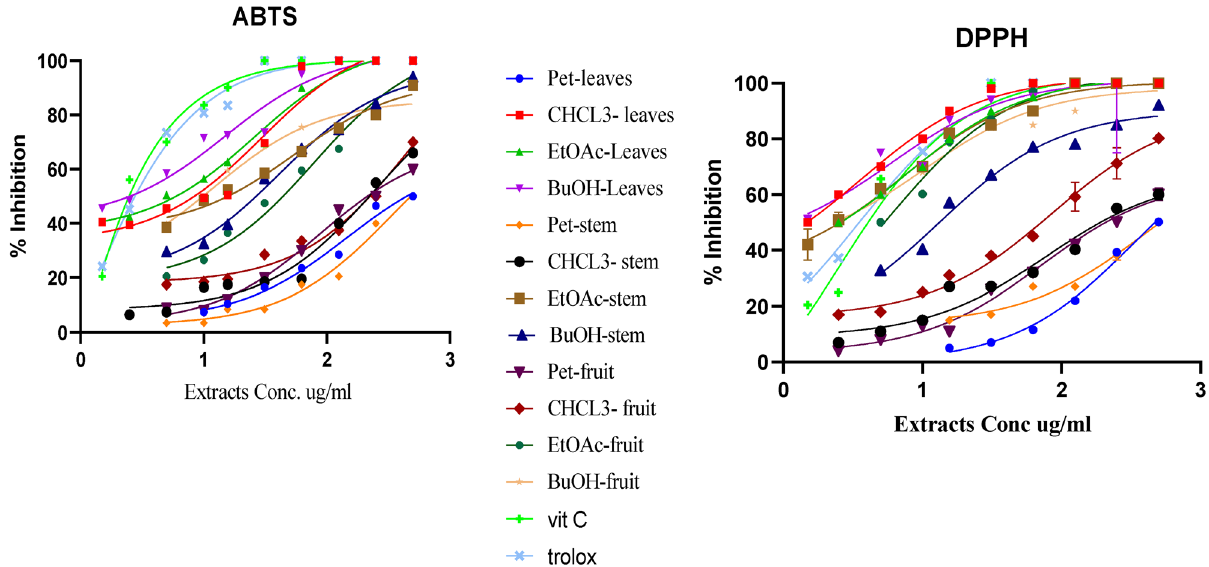
Figure 3. In vitro IC 50 DPPH and ABTS antioxidant activity of different plant parts of Musa acuminata extracts.